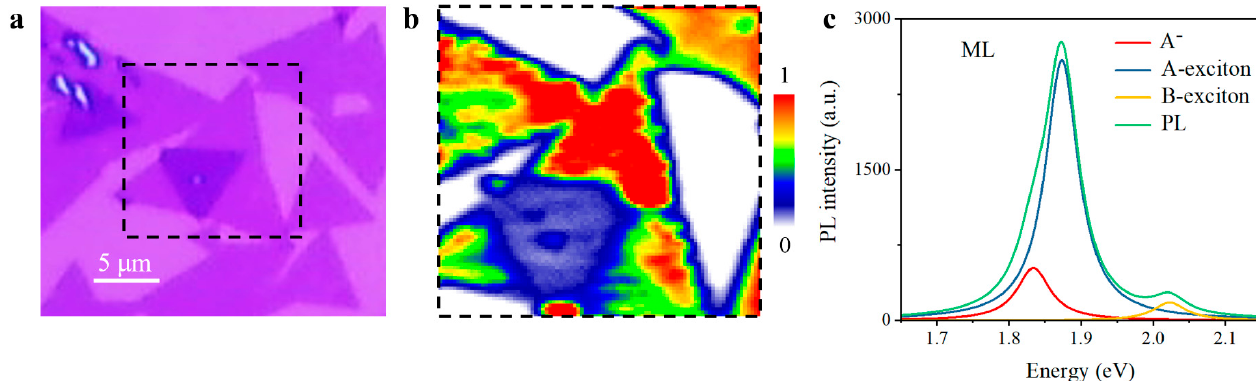
Figure 2. PL mapping of a twisted MoS 2 bilayer. ( a ) Optical image. ( b ) PL mapping result of region marked in ( a ). PL intensity is integrated within A-exciton resonance. ( c ) PL spectrum of monolayer MoS 2 . ML, monolayer; A - , trion.